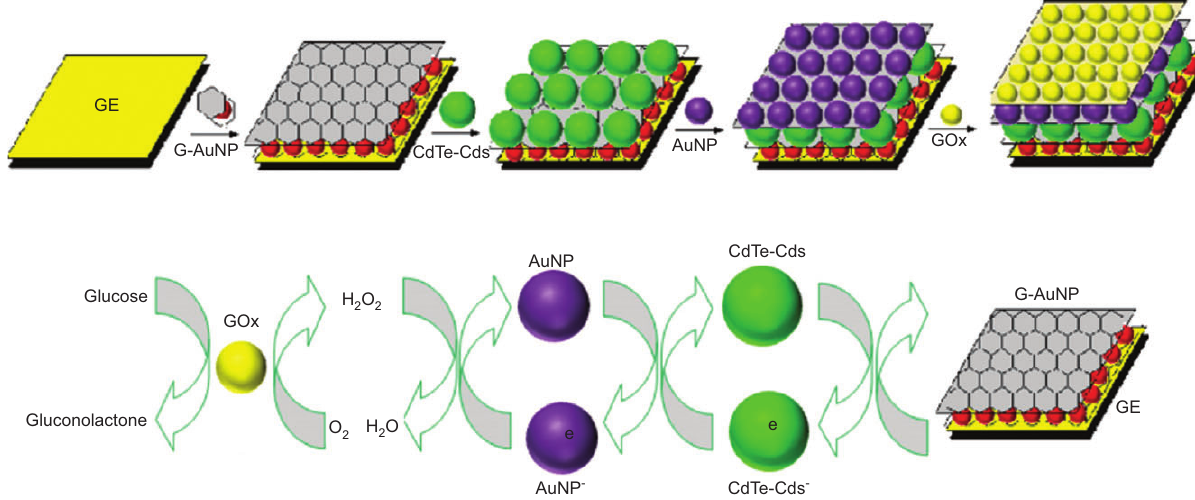
Figure 12 (A) Procedure for fabrication of GOx/AuNP/CdTe-CdS/G-AuNP/GE. (B) Electrocatalytic oxidation of glucose at the GOx/AuNP/ CdTe-CdS/G-AuNP/GE. From Ref. [110]